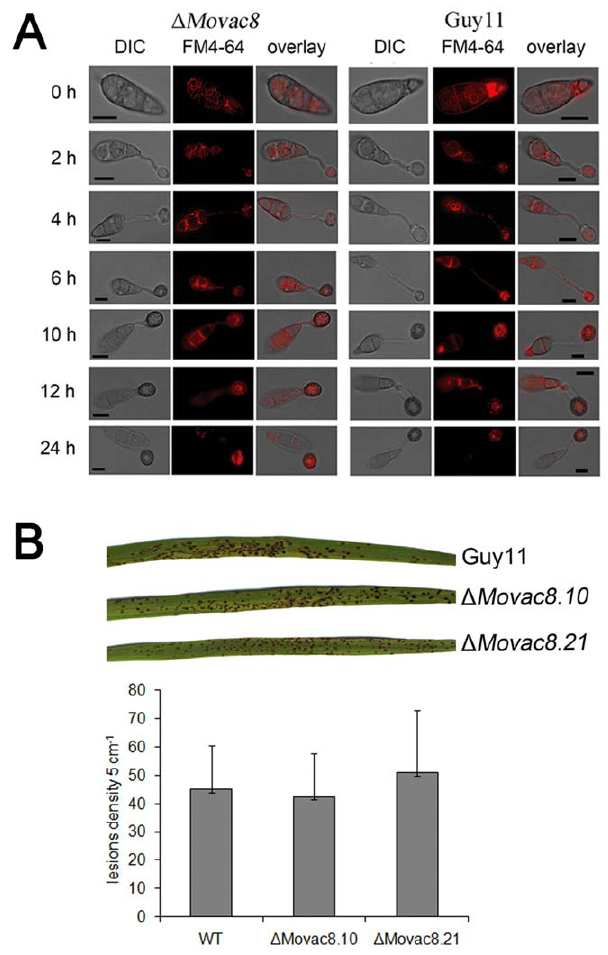
Figure 8. Phenotypic analysis of D Movac8 mutants. ( A ) MoVAC8 is not involved in vacuole movement from the conidium into